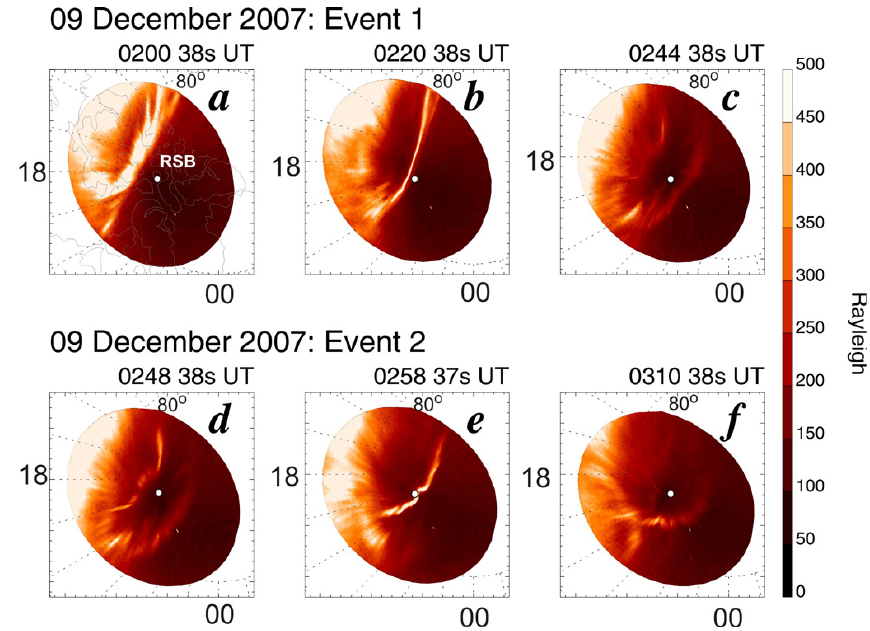
Fig. 2. A series of Resolute Bay all-sky camera images (630-nm emission) showing the progression of polar cap arcs for two events on 9 December 2007. Mapping is done in MLAT-MLT coordinates assuming a luminosity height of 250km. Panels (a) – (c) and (d) – (g) correspond to the events 1 and 2,